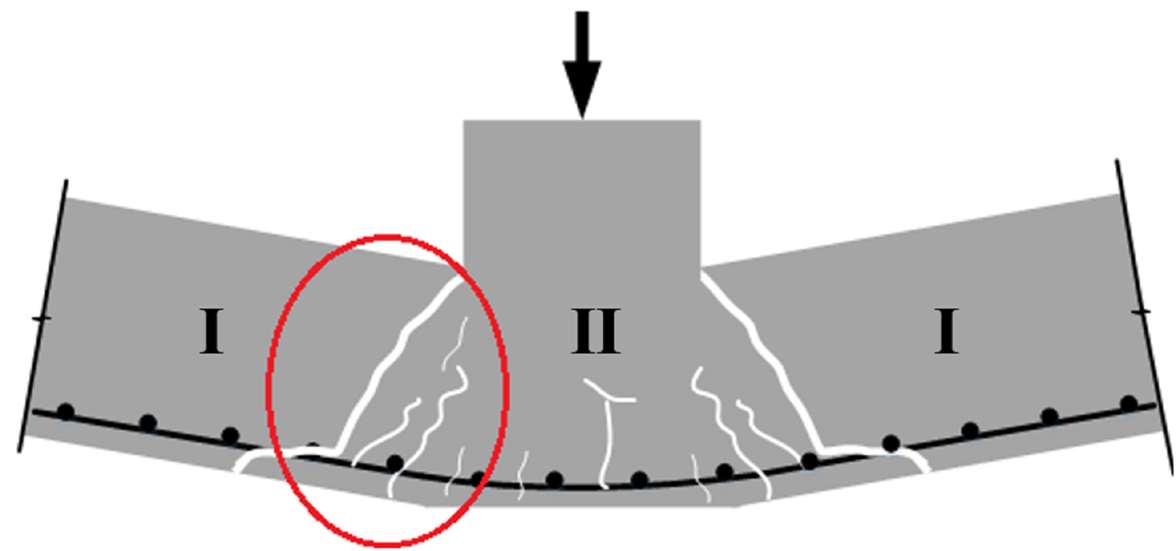
Figure 9. Schematic diagram of punching failure.